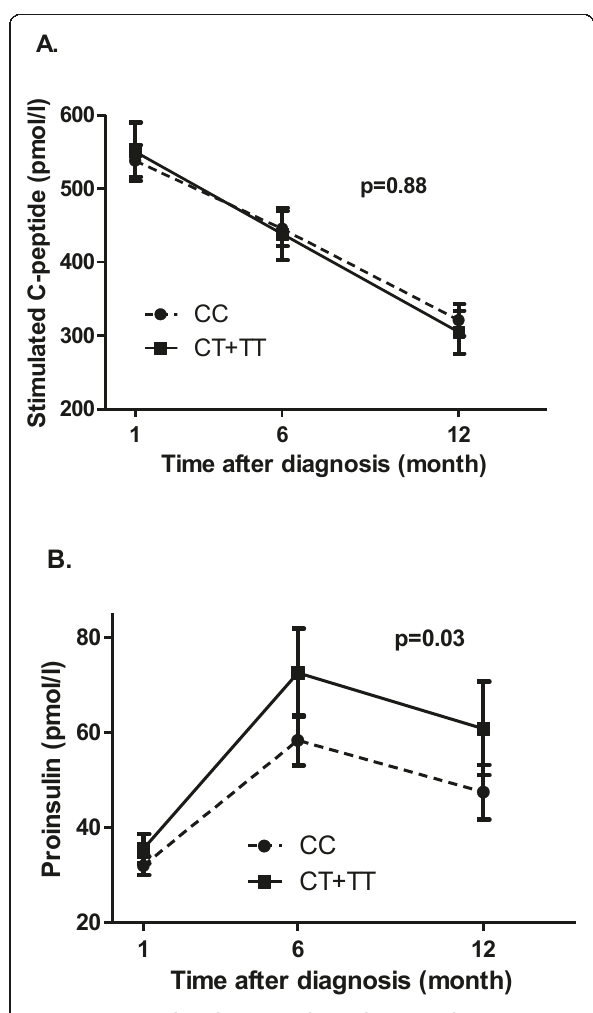
Figure 1 Stimulated C-peptide and proinsulin over time according to PTPN22 genotypes . The association of stimulated C- peptide (A.) and proinsulin (B.) level 1, 6 and 12 months after disease onset by PTPN22 genotype (homozygous+heterozygous (CT +TT) (n = 71) carriers of the variant versus wildtype (CC) (n = 186)). Mean values (pmol/l) ± SEM.